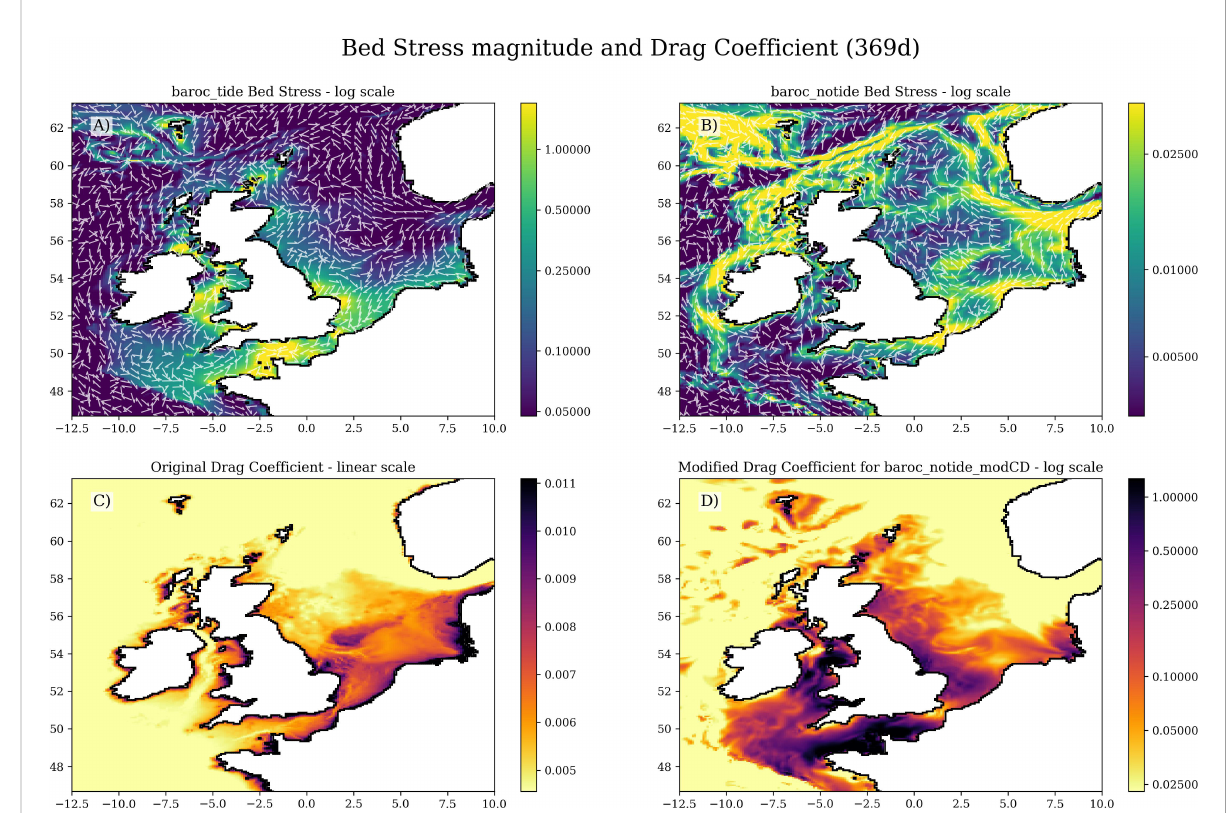
FIGURE 6 Bed stress magnitude (with arrows showing direction) and drag coef fi cients. (A, B) the mean bed stress in baroc_tide and baroc_notide respectively (both on log scale, but note the different ranges). (A, B) Are averaged over 369 days to average out the M 2 and S 2 constituents, and annual cycle. (C) The standard drag coef fi cient used in NEMO (used in both baroc_tide and baroc_notide), on a linear scale. (D) the modi fi ed drag coef fi cient (on a log scale, calculated from equation (10), used in baroc_notide_modCD) to increase the bed stresses in the non-tidal simulations to match that of the tidal